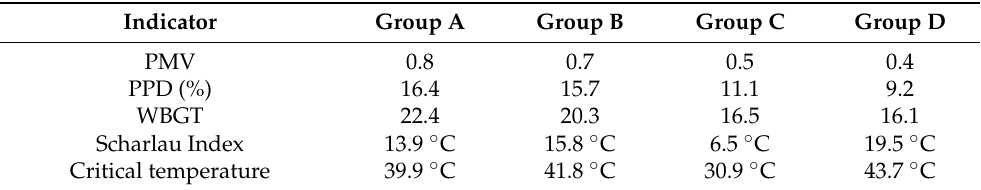
Table 5. Thermal indicators estimated using the DeltaOHM HD32.3 during the practical works of students (3 h).